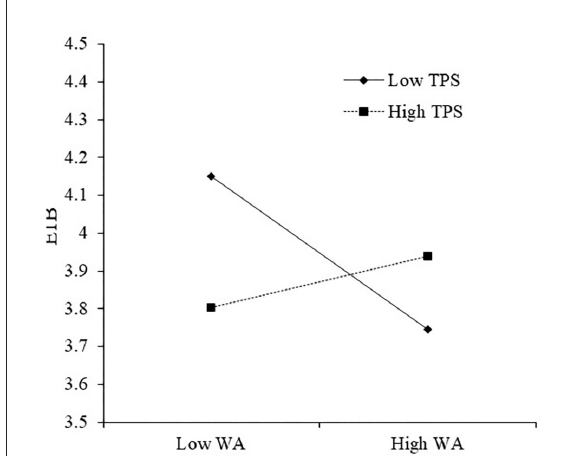
FIGURE2 Moderating role of TPS on the relationship between workplace anxiety and employee innovative behaviors.